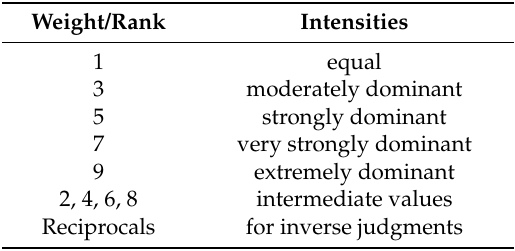
Table 1. Fundamental scale for pairwise comparisons in the AHP [54].